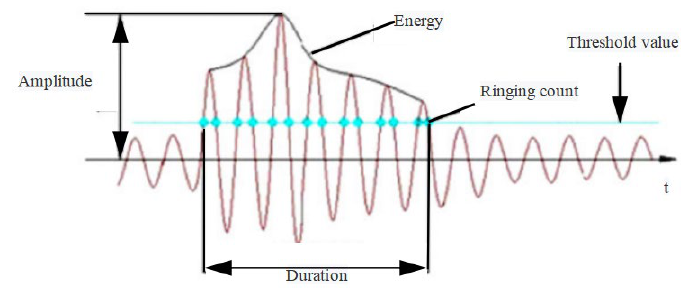
Figure 2. Acoustic emission damage waveform.